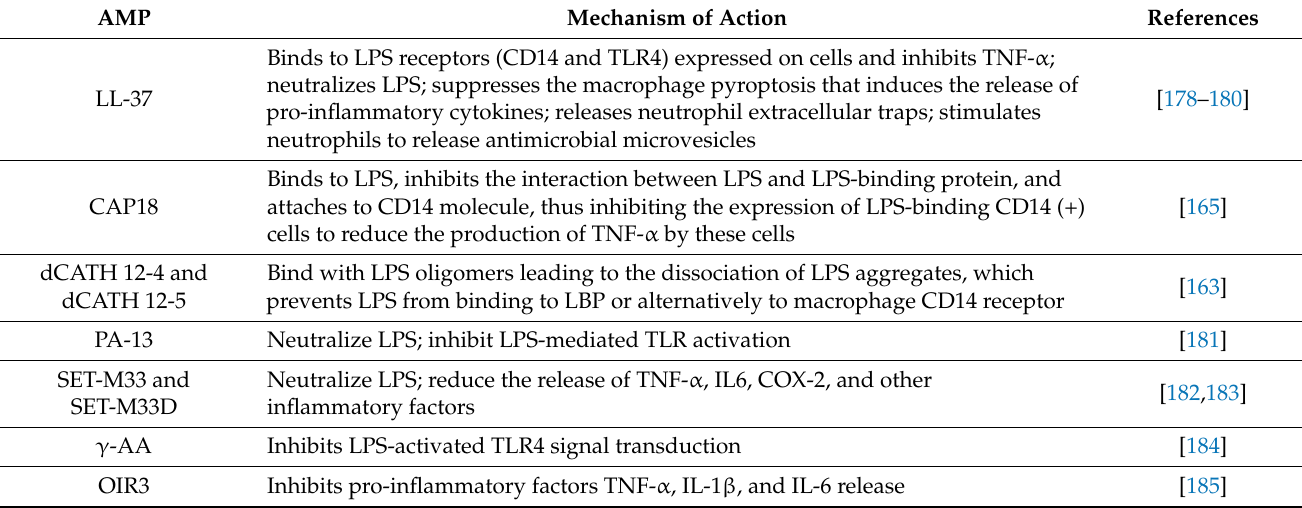
Table 4. AMPs with anti-inflammatory activity and the mechanism of action of each antibacterial peptide.